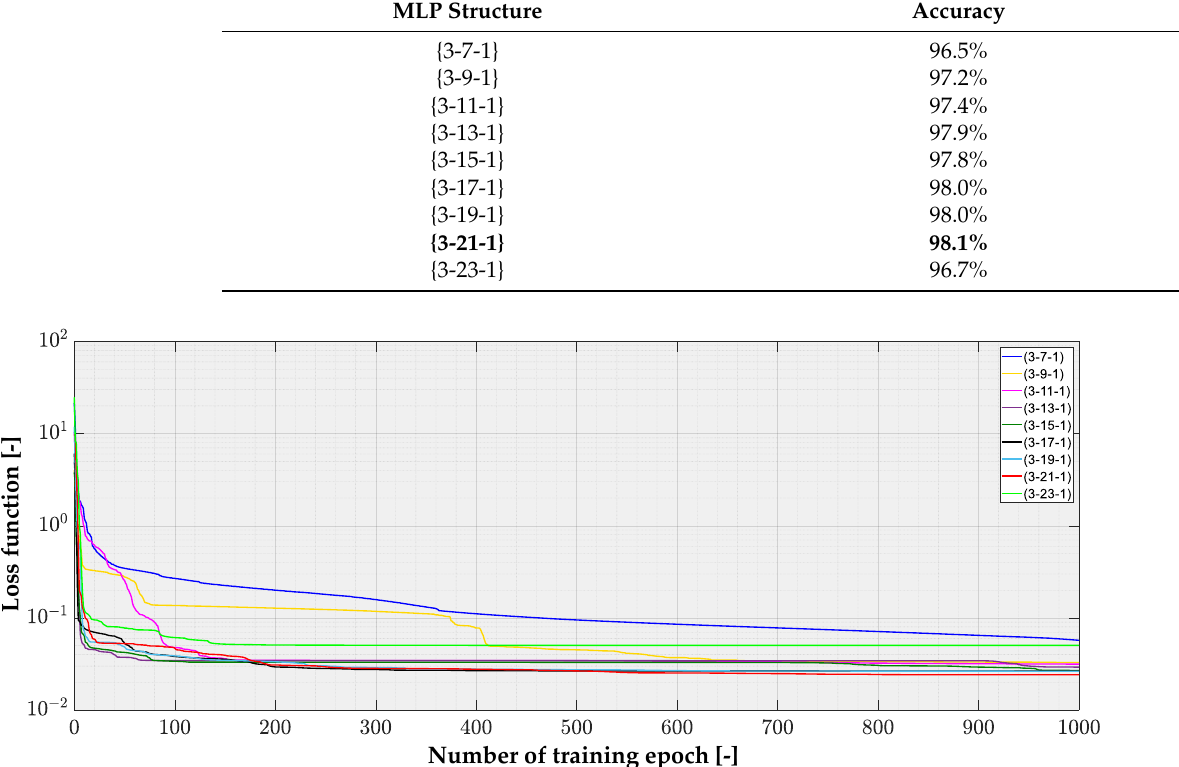
Table 1. MLP classifier accuracies for different structures of the network.